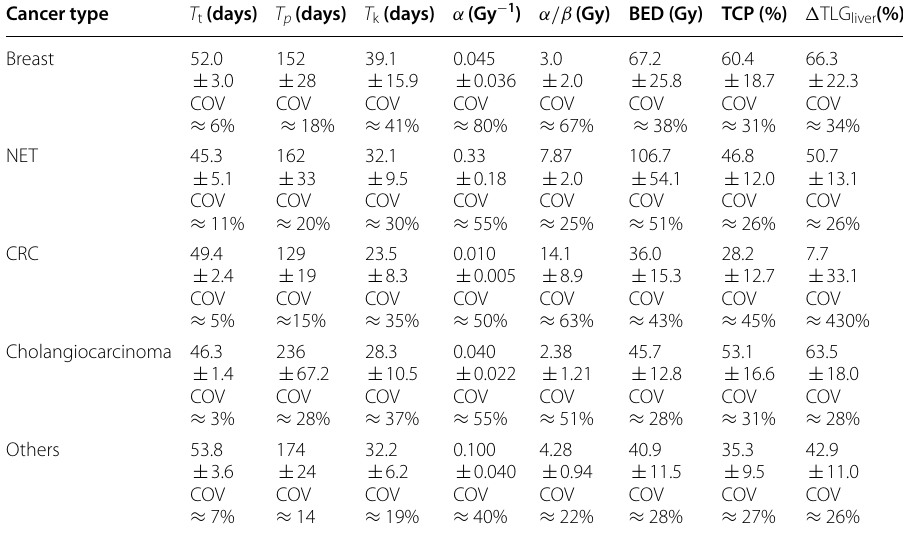
COV coefficient of